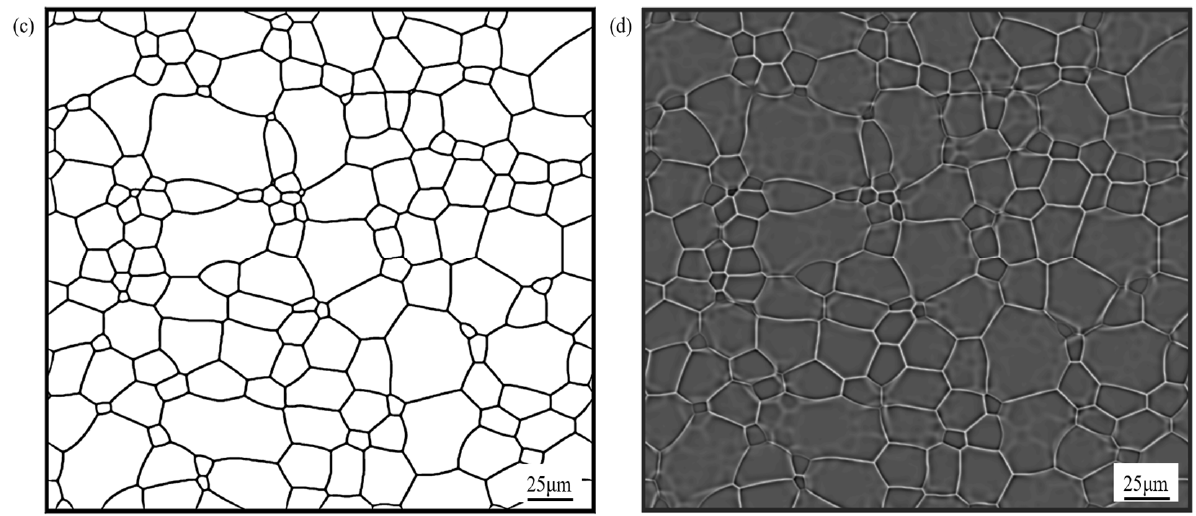
Figure 1. Simulation results of microstructure evolution when t = 30 min and 60 min at 350 °C : ( a , b ) for the order field at 30 min, 60 min; ( c , d ) for concentration field at 30 min, 60 min. The evolution of the microstructure of AZ31 Mg alloy containing SPP with time was simulated, and the results are shown in Figure 2.